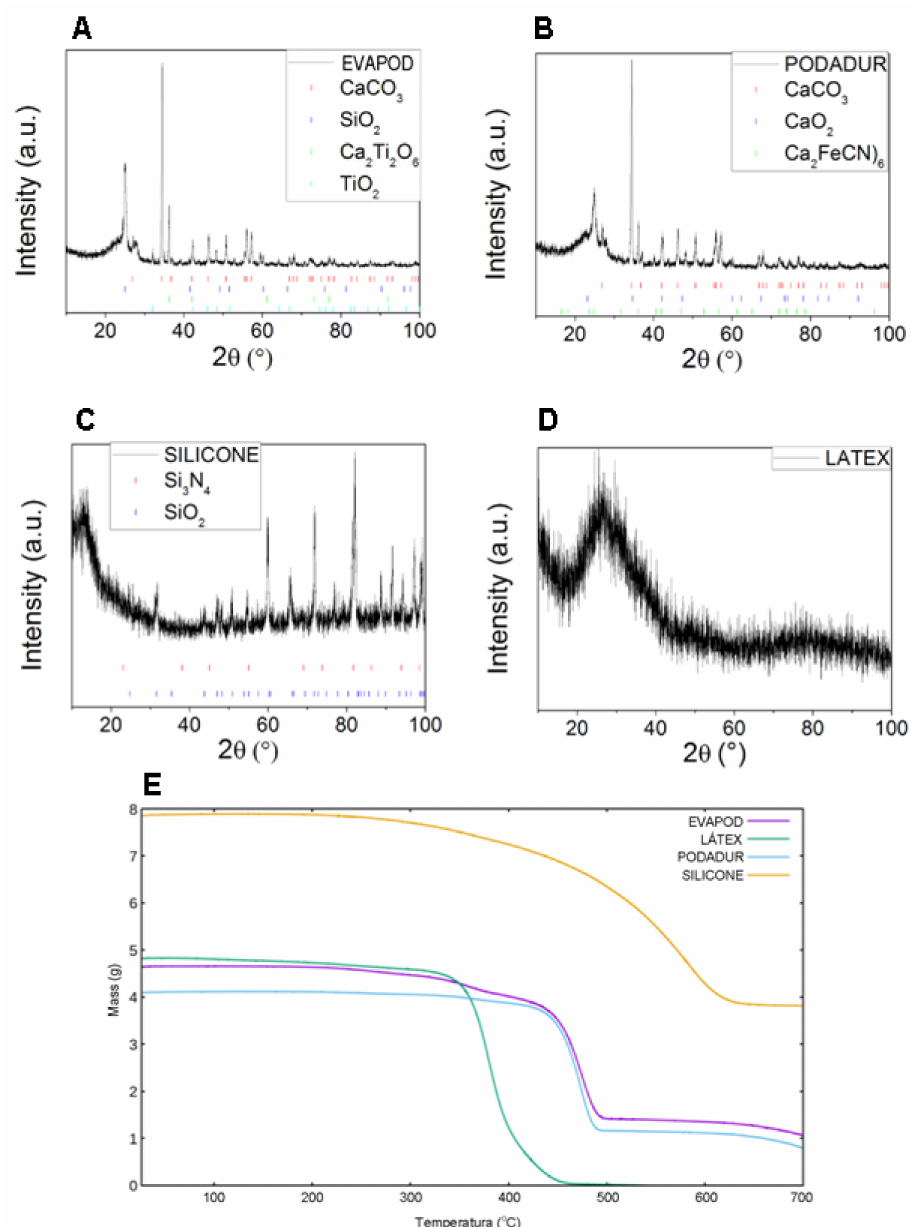
Figure 2. X-ray diffraction test and thermogravimetry. a.u. = arbitrary units. ( A ) Diffraction pattern of Evapod, presenting an amorphous and crystalline characteristic. Most intense peak with 610 counts, 2 θ = 34.5 ◦ and F.W.H.M. = 0.27 ◦ . 2 θ ranging between 10 and 100 degrees. ( B ) The diffraction pattern of the Podadur presents an amorphous and crystalline characteristic. Most intense peak with 483 counts, 2 θ = 34.4 ◦ and F.W.H.M. = 0.32 ◦ . 2 θ ranging between 10 and 100 degrees. ( C ) Diffraction pattern of silicone, with amorphous and crystalline characteristics. Most intense peak with 48 counts, 2 θ = 82.1 ◦ and F.W.H.M. = 0.43 ◦ . 2 θ ranging between 10 and 100 degrees. ( D ) Diffraction pattern pattern of the analyzed